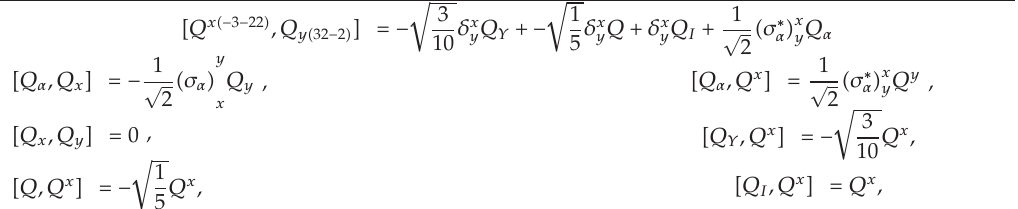
x (cid:2) 32 − 2 (cid:3) , Q α , Q Y , Q , and Q I .